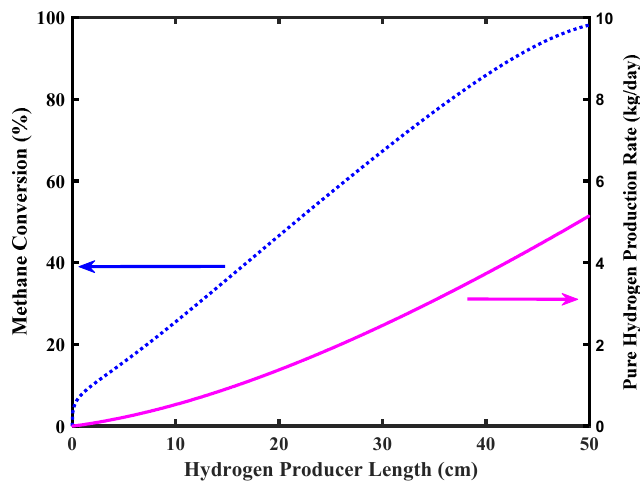
Figure 7. Methane conversion and pure hydrogen production rate of the MR, Pd-Ag membrane thickness = 50 µm, water to methane ratio = 2.5, inlet temperature = 500 °C, and inlet pressure = 10 bar.